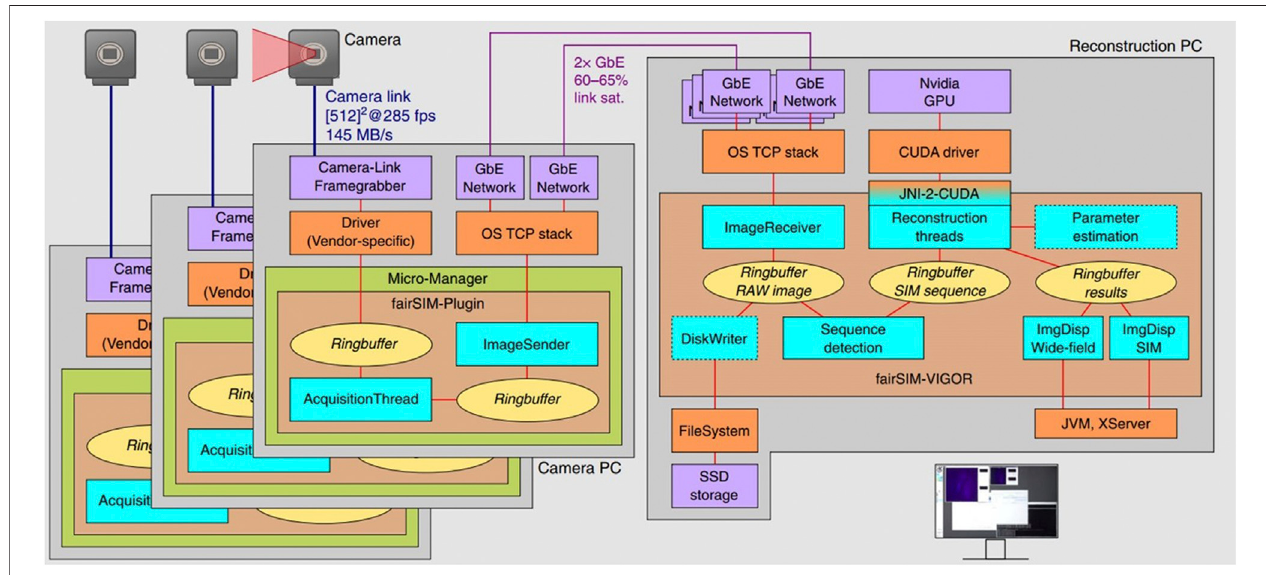
FIGURE 7 | Structure of the real-time reconstruction software fairSIM-VIGOR [62]. These schematics show the data fl ow of the raw images through the on-the- fl y reconstruction pipeline, which from sCMOS to Camera PC is on the left part of the fi gure (note that there are three of these systems working simultaneously) and from Camera computers toReconstruction PC ison the right part ofthe fi gure.The left part ofthe image shows the data fl ow within each cameraPC and the right part is fl ow through the reconstruction PC. The fi gure is modi fi ed with permission from Ref. (62). Copyright © 2019 Springer Nature.